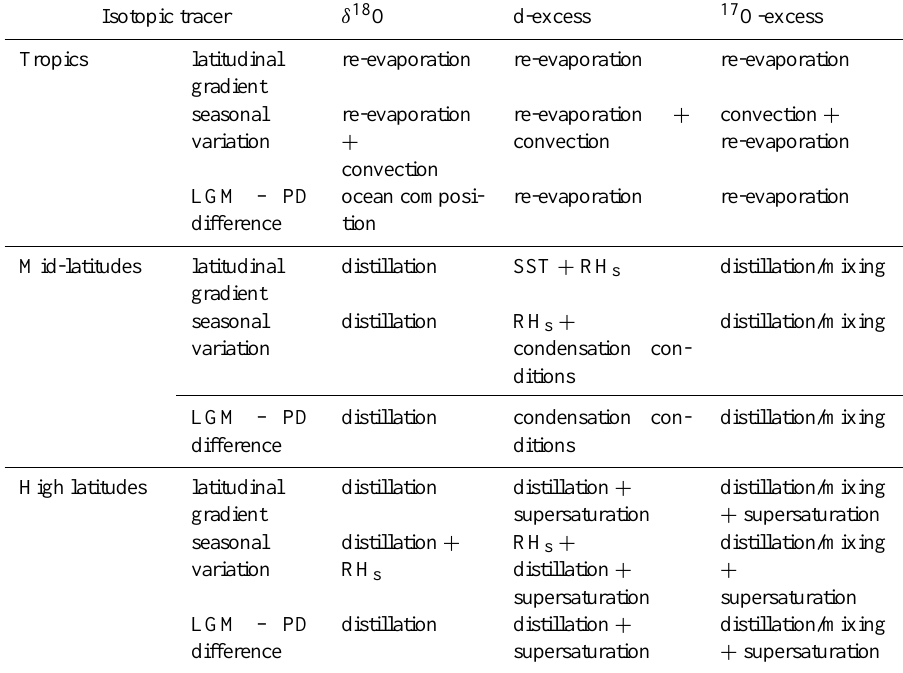
Table 5. Summary of the main processes explaining the main features of the δ 18 O , d-excess and 17 O -excess spatio-temporal distribution in the LMDZ model, as a function of latitude. The physical meaning of these processes are detailed in Sect. 4. Mixing refers to mixing of water vapor of different